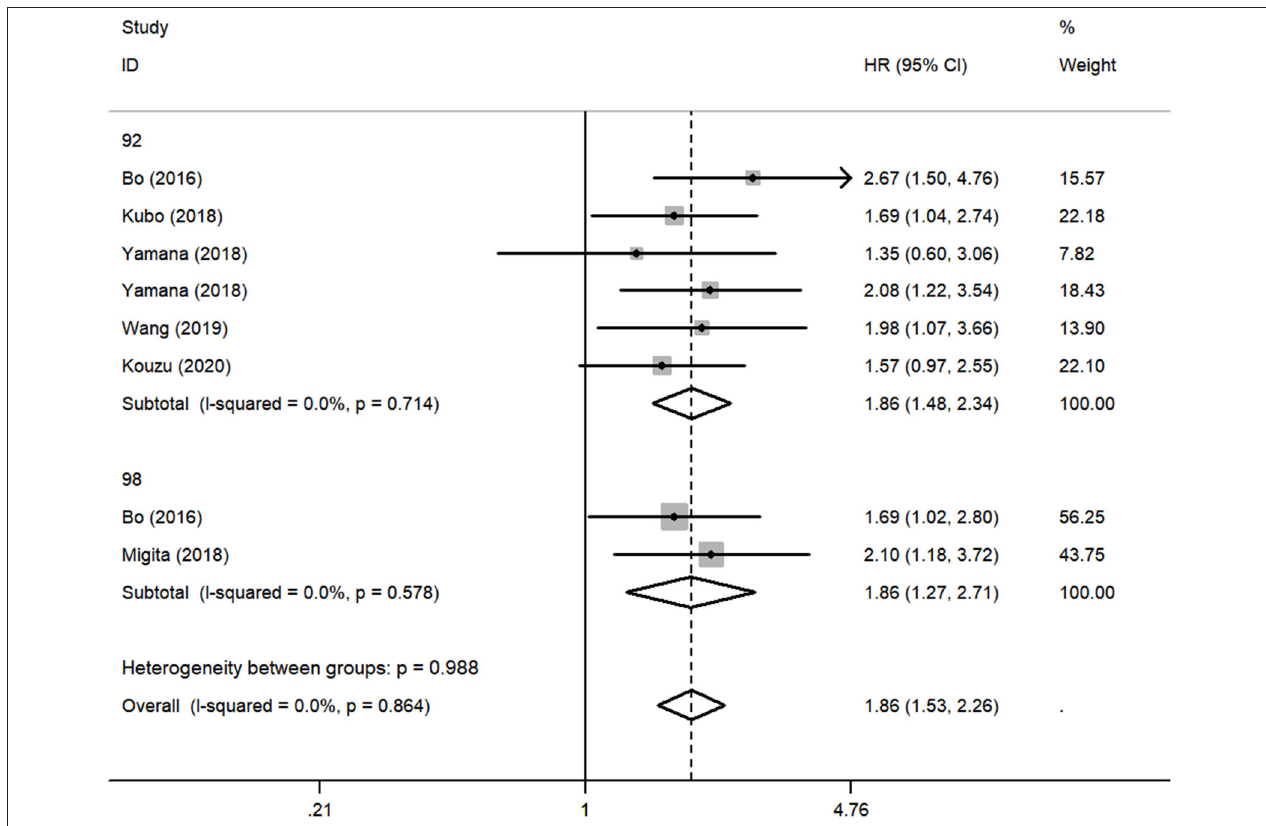
FIGURE 3 | Forest plot showing subgroup analysis of the selected studies about the prognostic significance of GNRI in patients with different cutoff